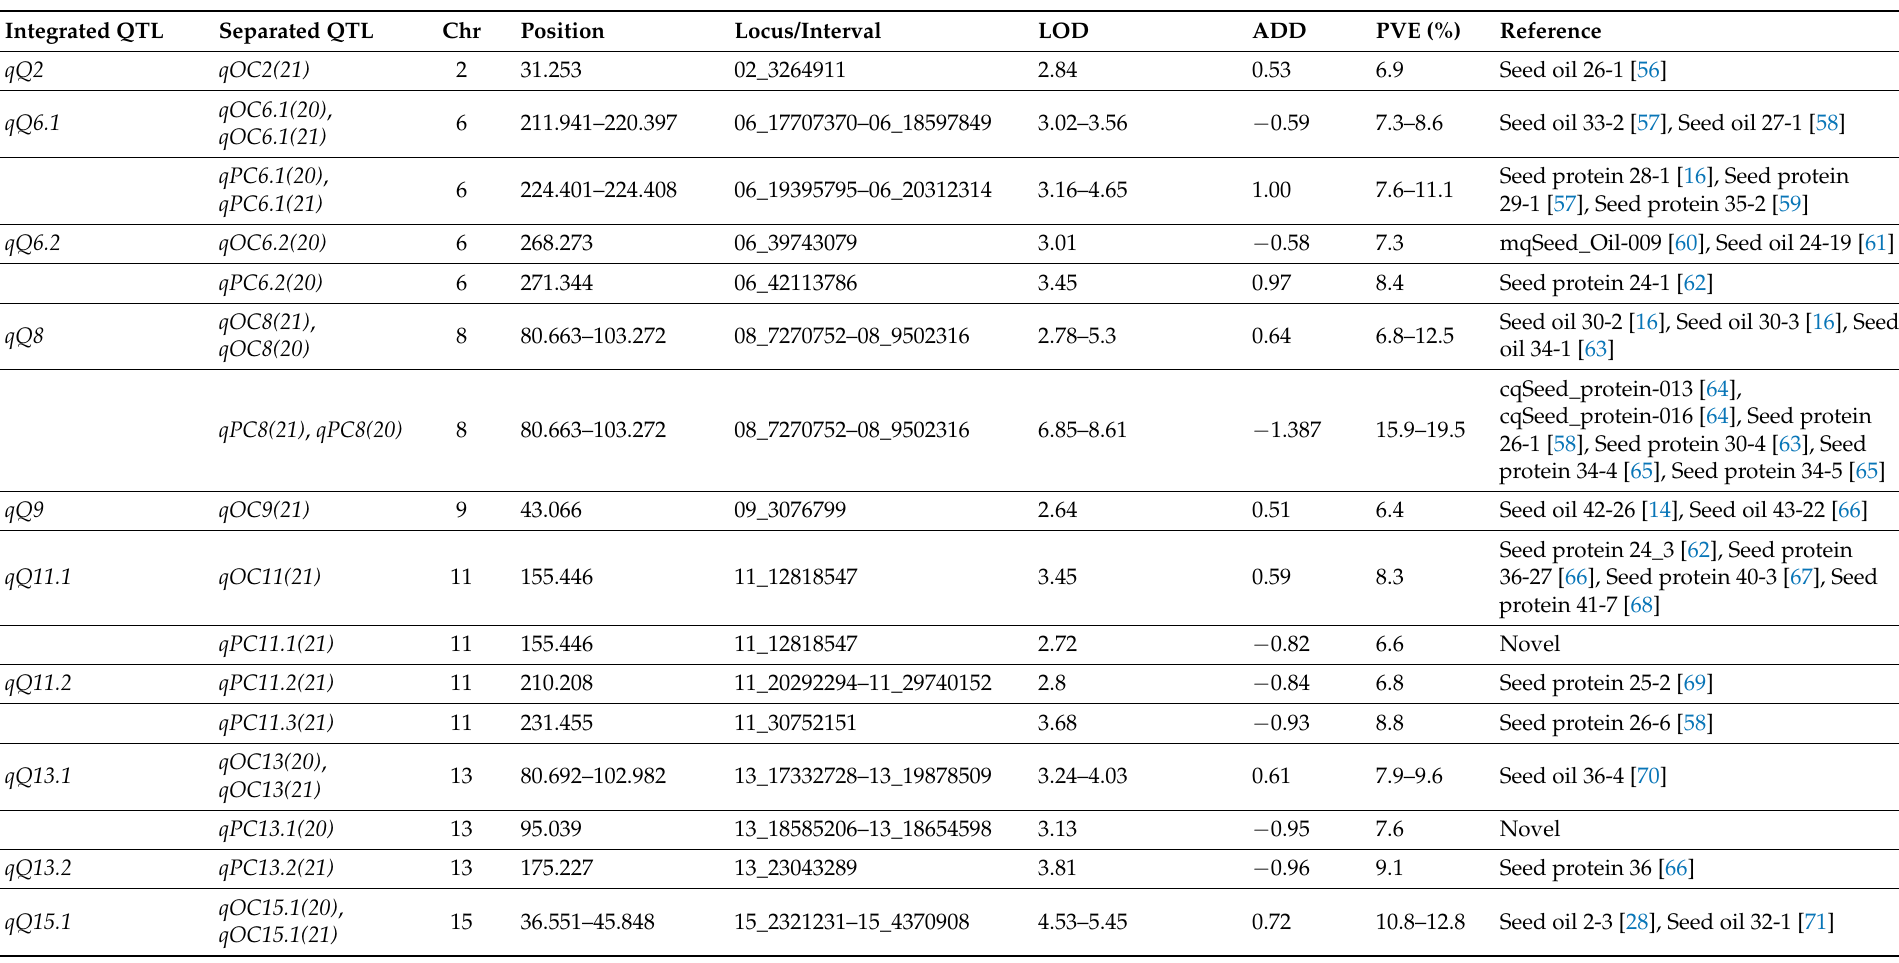
Table 4. Putative QTLs for soybean protein and oil content detected in a population of contrasting soybean parents and 185